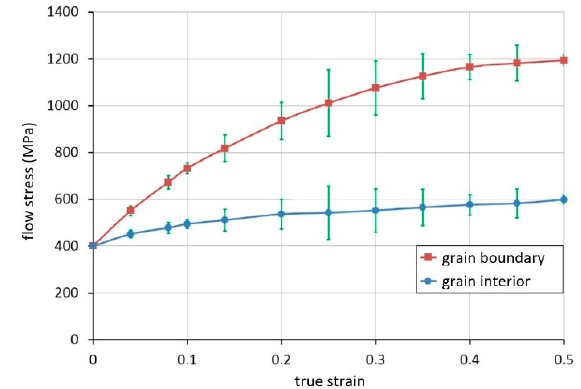
Figure 4. Flow curves for boundary and interior grains , a diagram obtained based on a uniaxial